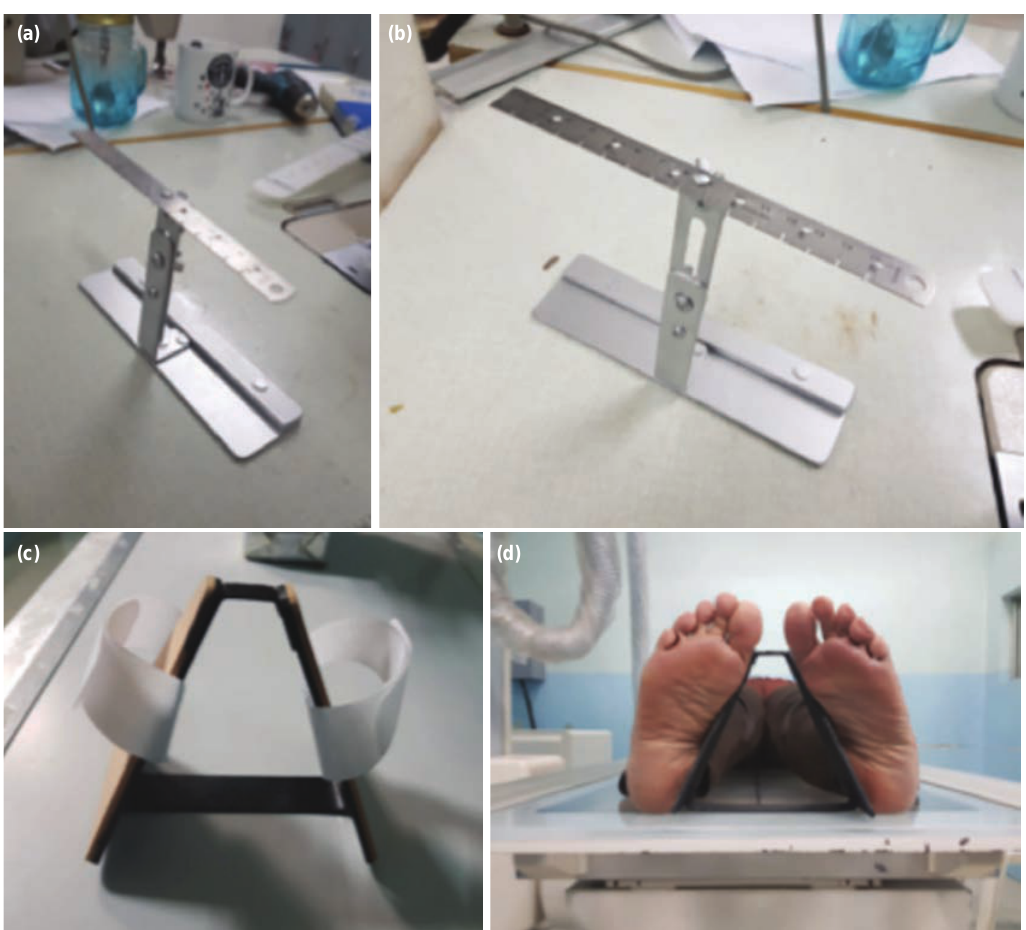
(a, b) Radiographic ruler with adjustable height, (c, d) 20° internal rotation foot angle guide with base at 20cm apart. Fig. 1: